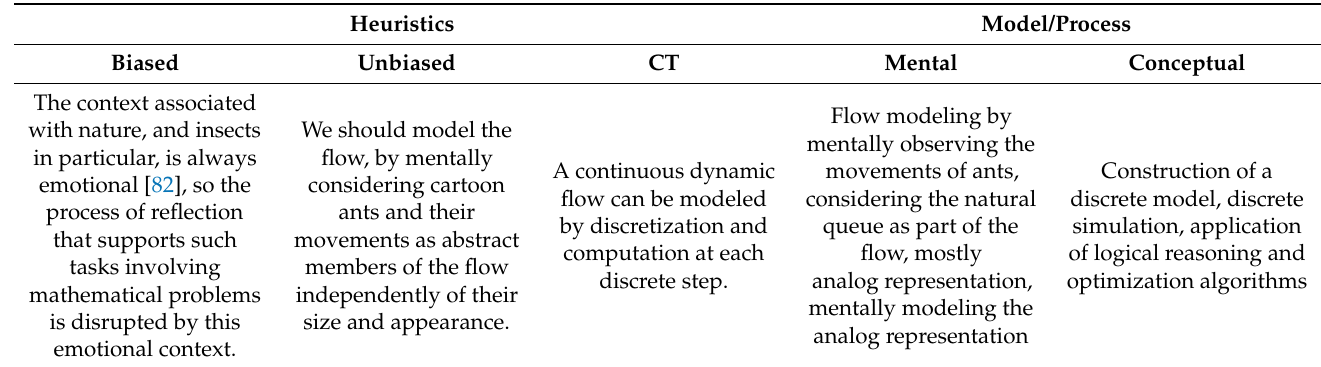
Figure 7. A sample of the Bebras short task on optimization for secondary level (age 12–14). Retrieved by permission from www.bebras.org (accessed on 24 February 2022). Table 3. A case of the Bebras short task on optimization problem aimed at scaffolding CT mindset (elaborated by the authors).